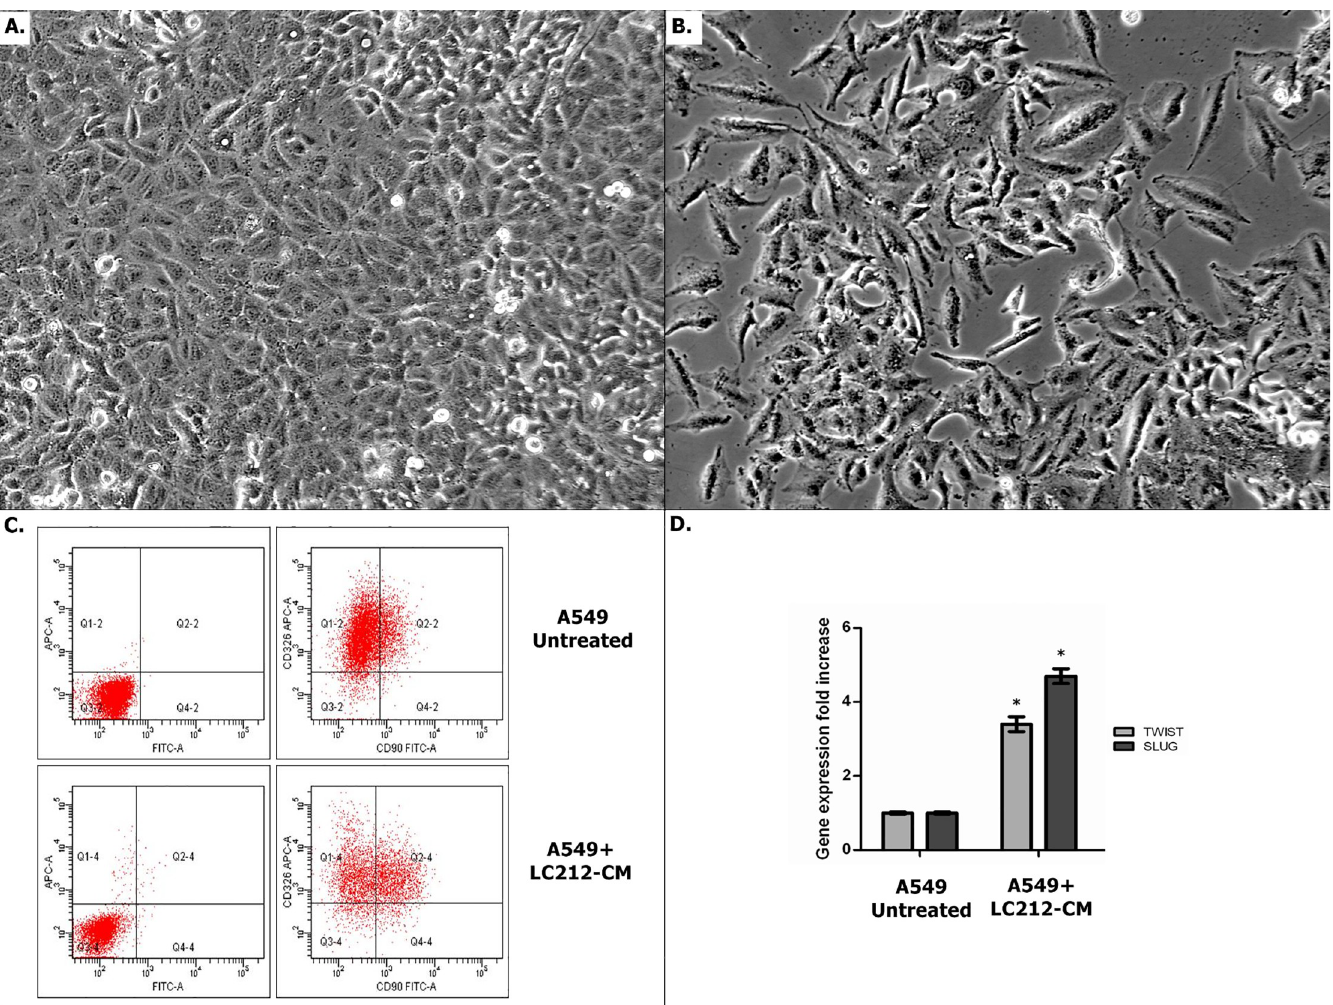
Fig 2. Effect of LC212-CM on A549 cell line. (A,B) Optical microscopy of A549 cells showed the morphological effect induced by LC212-CM. LC212-CM induced morphological changes resembling mesenchymal cells-like morphology; conversely, no shape changes have been observed if standard medium were used. Scale bar = 50 μ m. (C) EMT characterization by flow cytometry evidenced the over-expression of CD90 and down-regulation of CD326 on A549 treated with LC212-CM respect to untreated A549 cells; (D) TWIST and SLUG Real Time expression in A549 cells treated with LC212-CM. The data showed an up-regualtion of these genes respect to untreated A549 cells. � p < 0.03 compared to the untreated